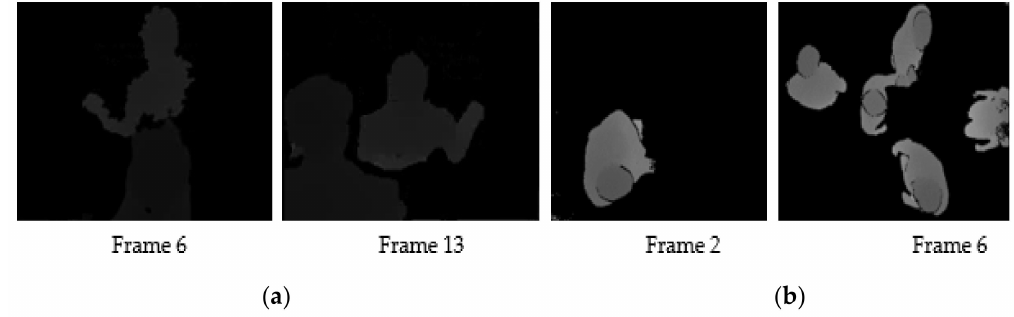
Figure 2. Results obtained after background subtraction using the KDE technique over ( a ) PCDS dataset and ( b ) GOTPD